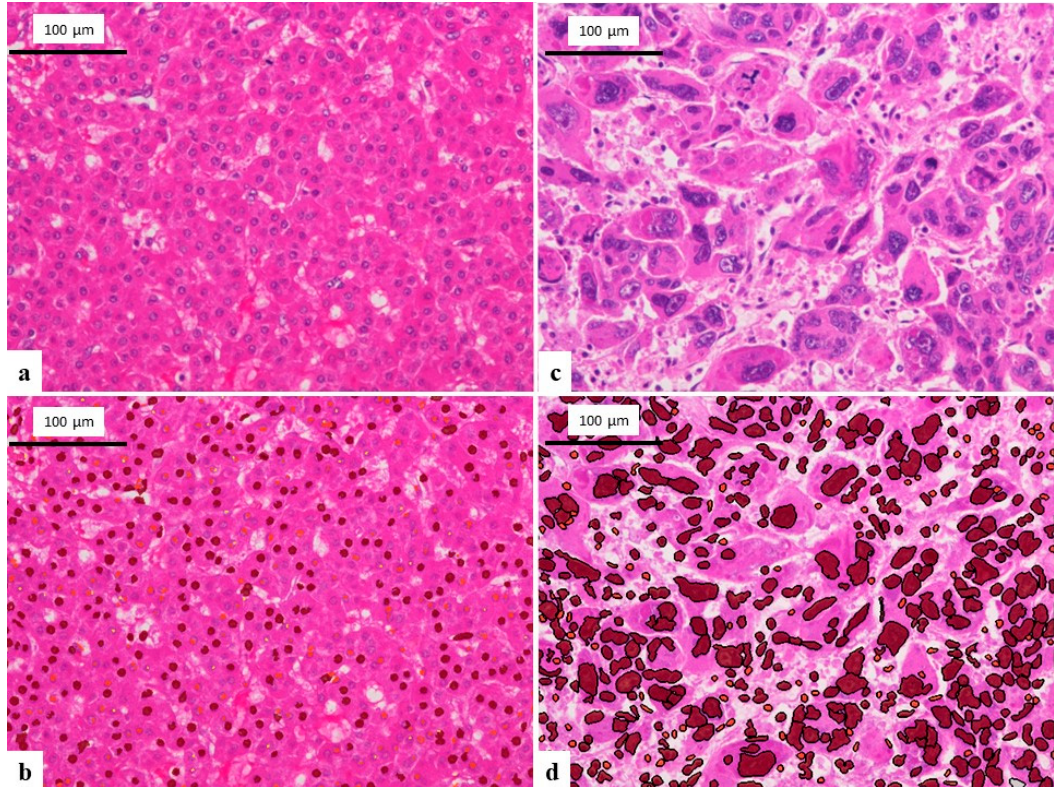
Figure 1. Analyzing images of HE-stained tissue section using Tissue Studio. ( a ) Image of well differentiated HCC (×200). ( b ) Analyzing image of Figure 1a. The software appropriately recognizes the nuclei of tumor cells and calculate major axis, minor axis, and area of the nucleus. ( c ) Image of poorly differentiated HCC (×200). The tumor cells are significantly larger than well differentiated HCC. ( d ) Analyzing image of Figure 1c. The software appropriately recognizes the nuclei of tumor cells although the nuclei are markedly pleomorphic.